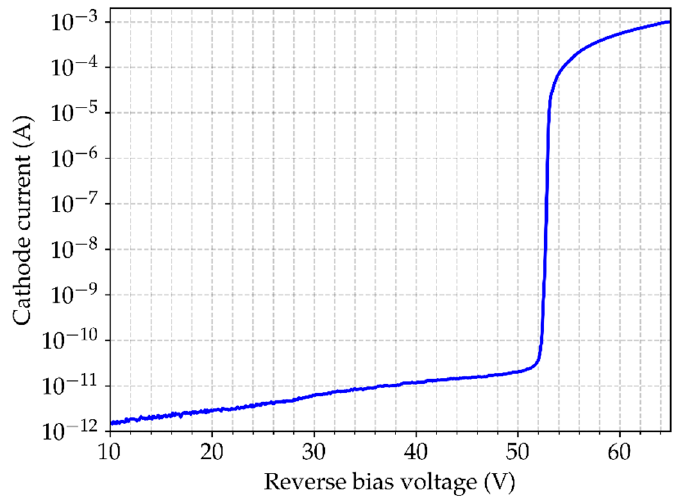
Figure 4. Measured IV characteristics of the detector in the dark (with anode-ring voltage of 15 V).